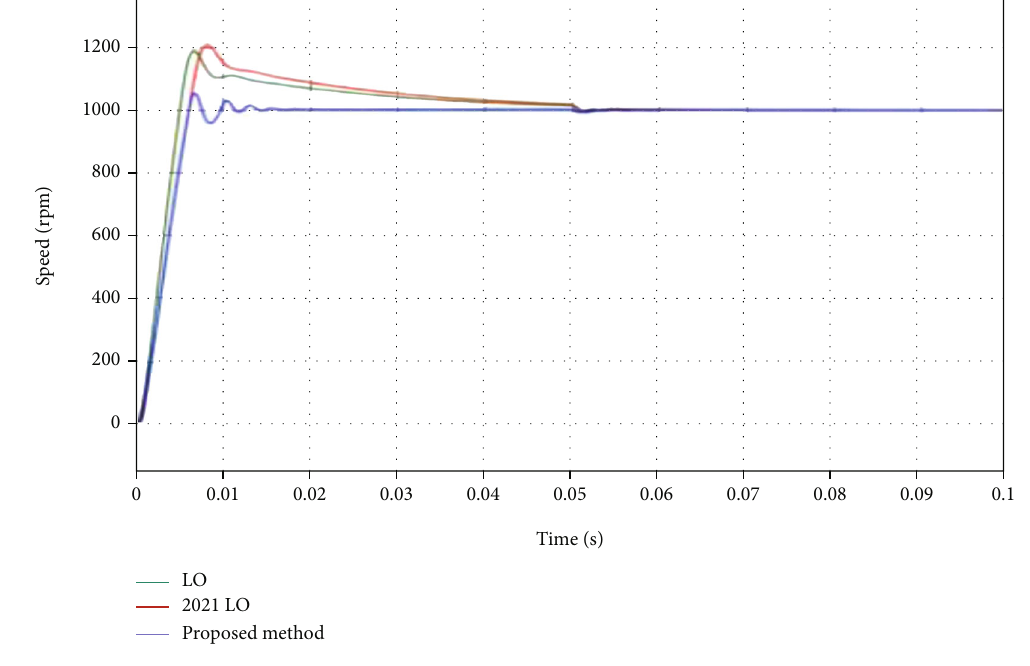
Figure 11: Comparison of speed curve. Table 7: Comparison of optimization performance.